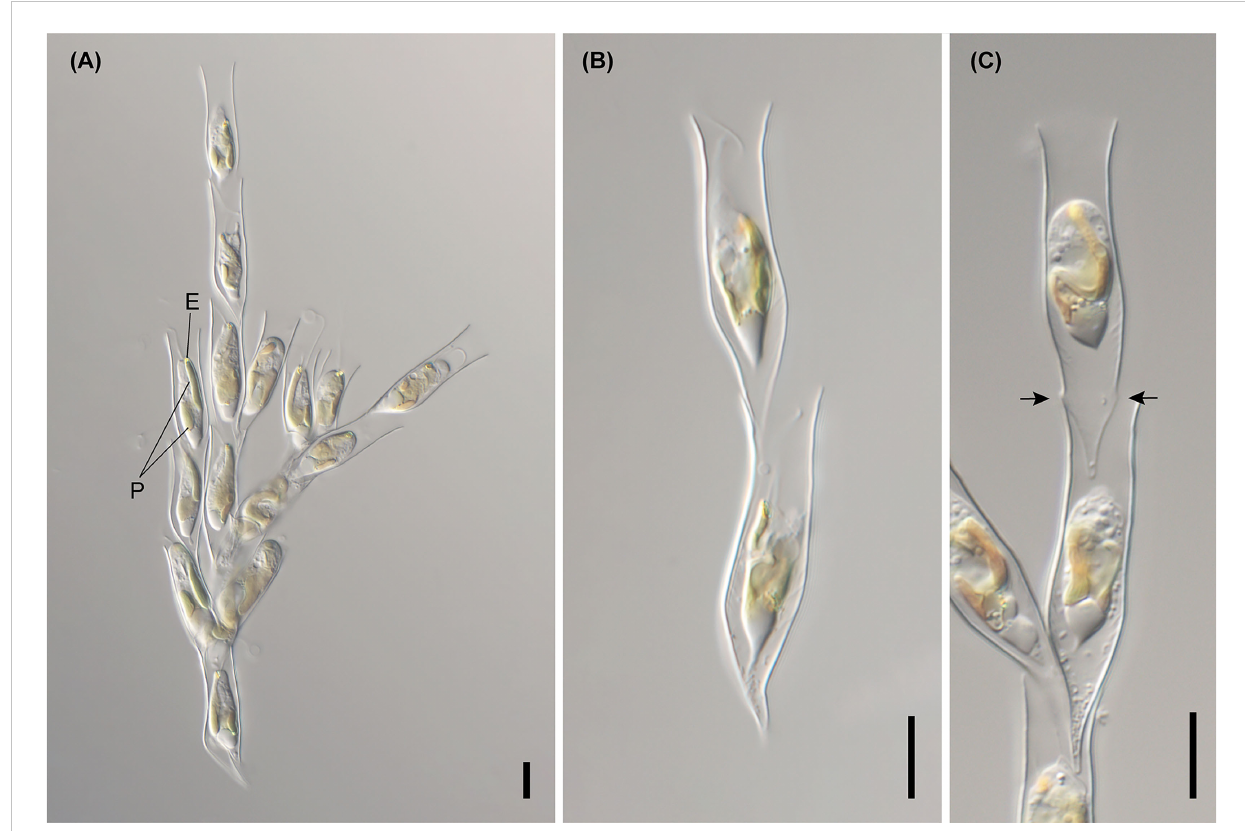
FIGURE 9 Light micrographs of D. cylindricum var. palustre Bonghwa040718C. (A) Colony morphology. (B, C) Lorica morphologies. Two protuberances are in both sides of the lower lorica part (arrow). E, eyespot; P, plastid. Scale bars = 10